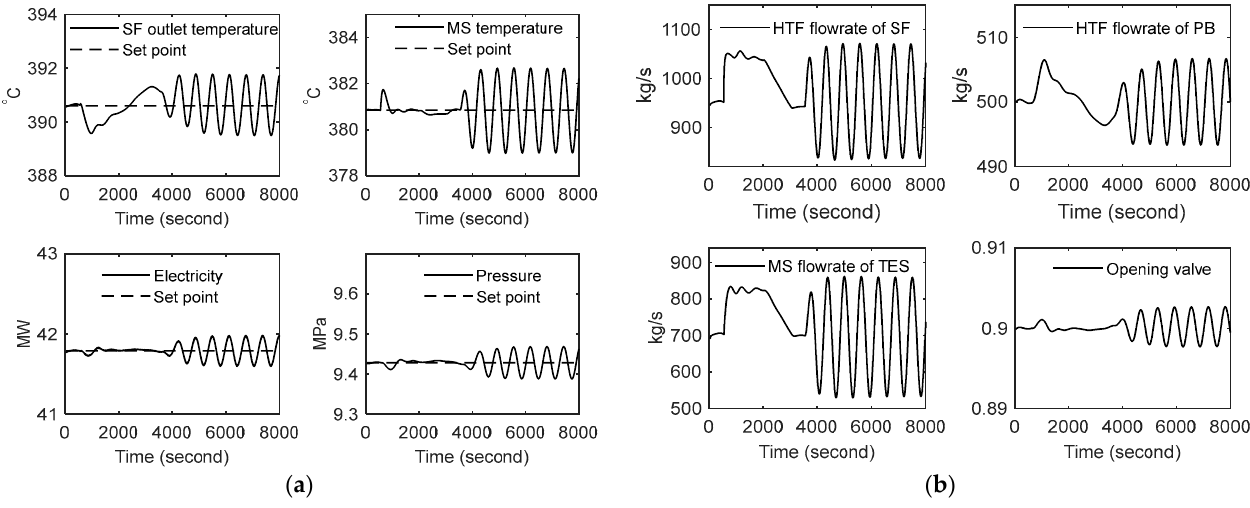
Figure 13. Simulation of disturbance rejection performance: ( a ) the controlled variables; ( b ) the manipulated variables.